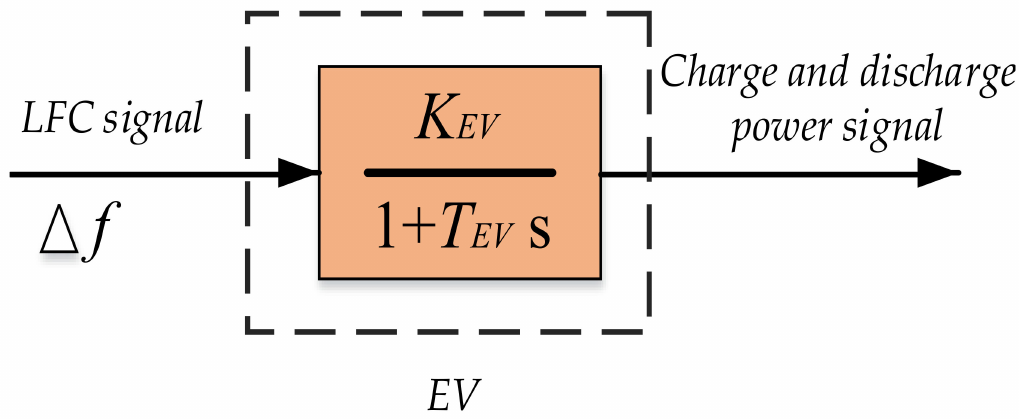
Figure 7. The implemented model of the electrical vehicle using MATLAB/Simulink